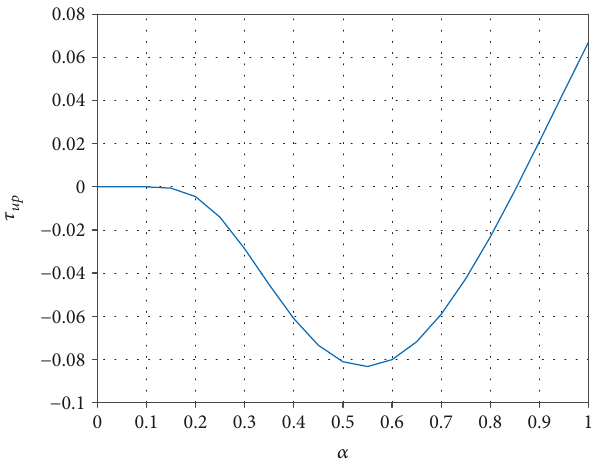
α when γ = 0 1 in case up and